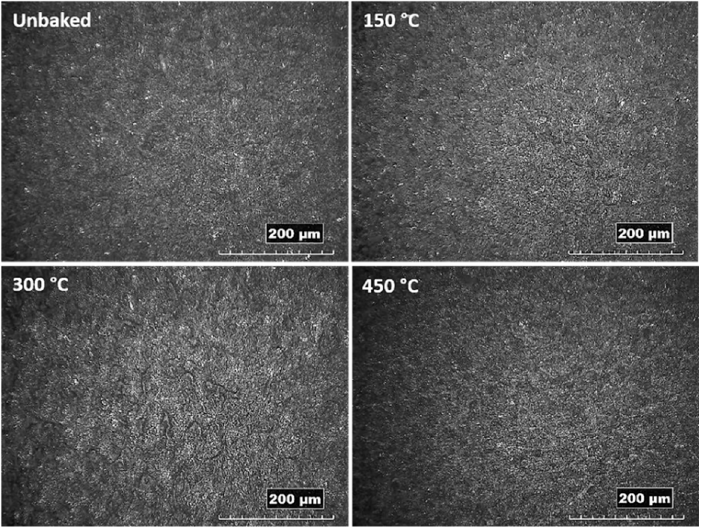
Figure 2. Images of the coated and heat-treated samples acquired by stereoscope.